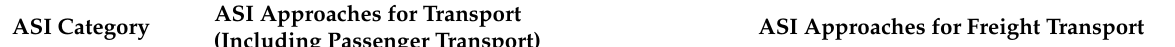
Table 1. Comparison of the Traditional ASI Framework and ASI for Freight Transport.